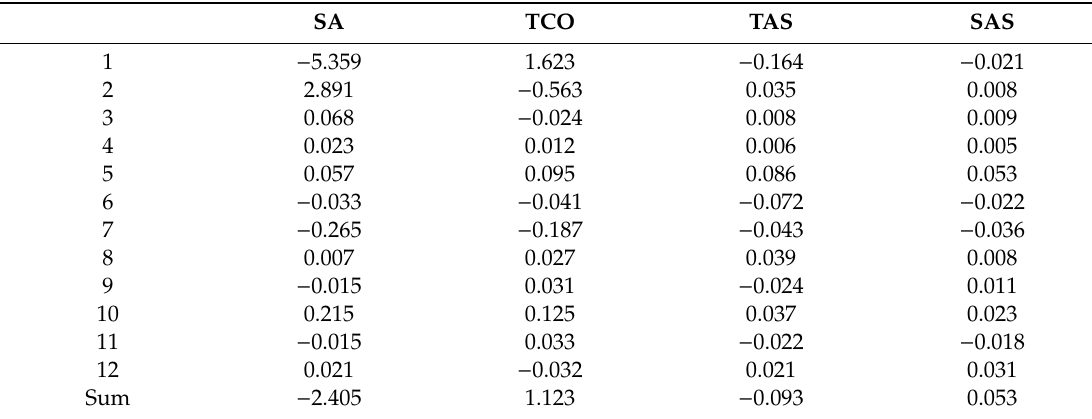
Figure 5. Analysis of temperature distribution after 1 h. Table 3. Third-order aberration analysis in the original thermal control state.